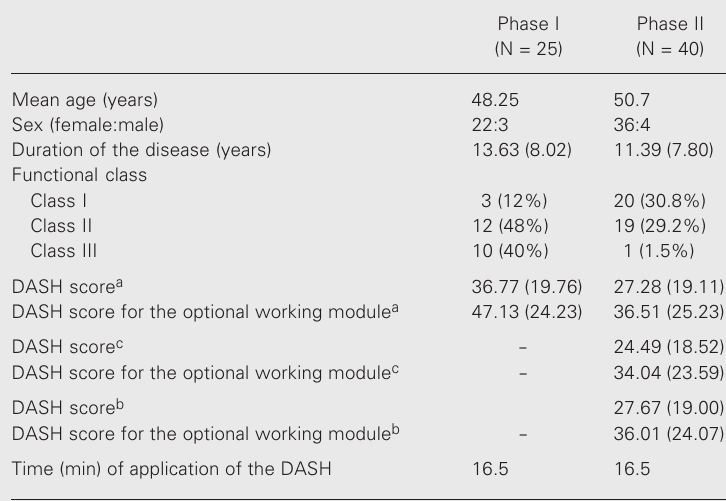
Table 1. Clinical and demographic characteristics of the 65 patients with rheumatoid arthritis, 25 included during the phase of cultural adaptation of the Portuguese version of the Disabilities of the Arm, Shoulder and Hand (DASH) Questionnaire (phase I) and 40 during the phase of intra- and interobserver reliability assessment (phase II).